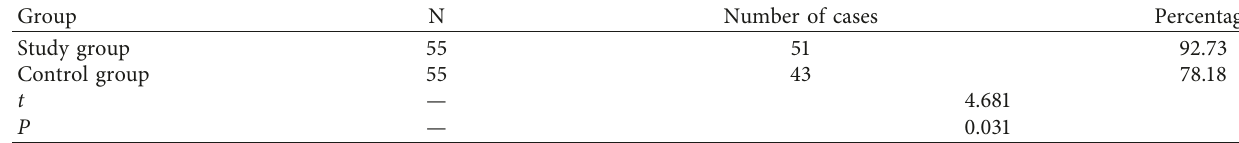
Table 3: Comparison of the rescue success rate between the two groups (n, %).